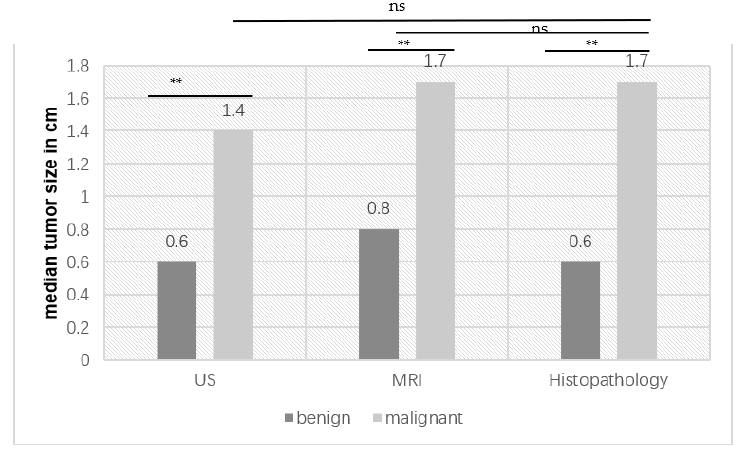
Figure 2. Median tumor size of benign and malignant tumors in ultrasound (US), magnetic resonance imaging (MRI) and histopathology (** p < 0.001) (ns = not significant). Table 4. Selected p -values comparing clinical and diagnostic parameters of the two subgroups of patients with benign and malignant histopathology (* p < 0.05, ** p < 0.01).